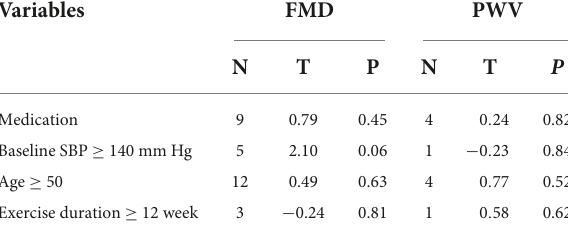
TABLE 2 Meta-regression analyses on FMD and PWV in studies included in the meta-analysis.